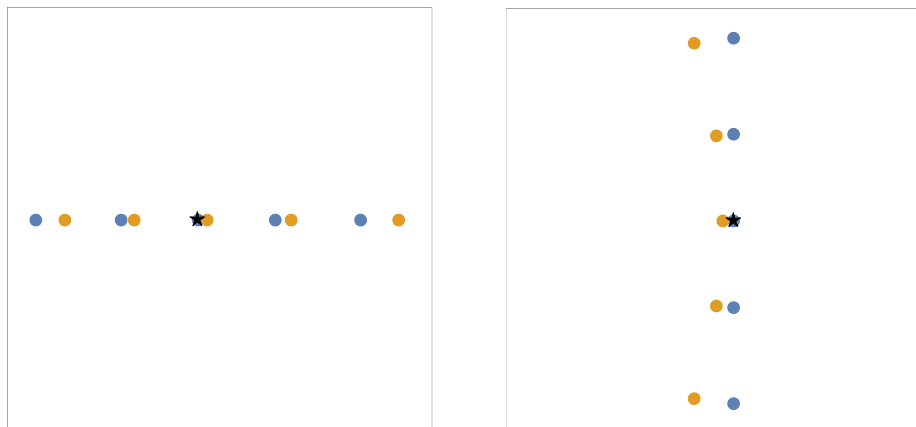
Figure 2 . On the left, the case of the non-degenerate partition (5) , and on the right the conjugate case (1 , 1 , 1 , 1 , 1) . In yellow the numerical solution, in blue the perturbative solution according to formula (10.1). The star is the point z = L